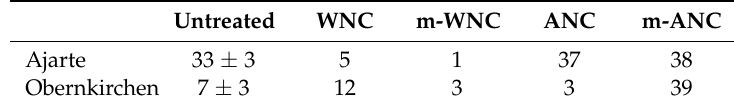
Table 6. Values of root mean square (RMS) surface Roughness (nm) of Ajarte and Obernkirchen stones: untreated and treated with WNC, m-WNC, ANC and m-ANC.